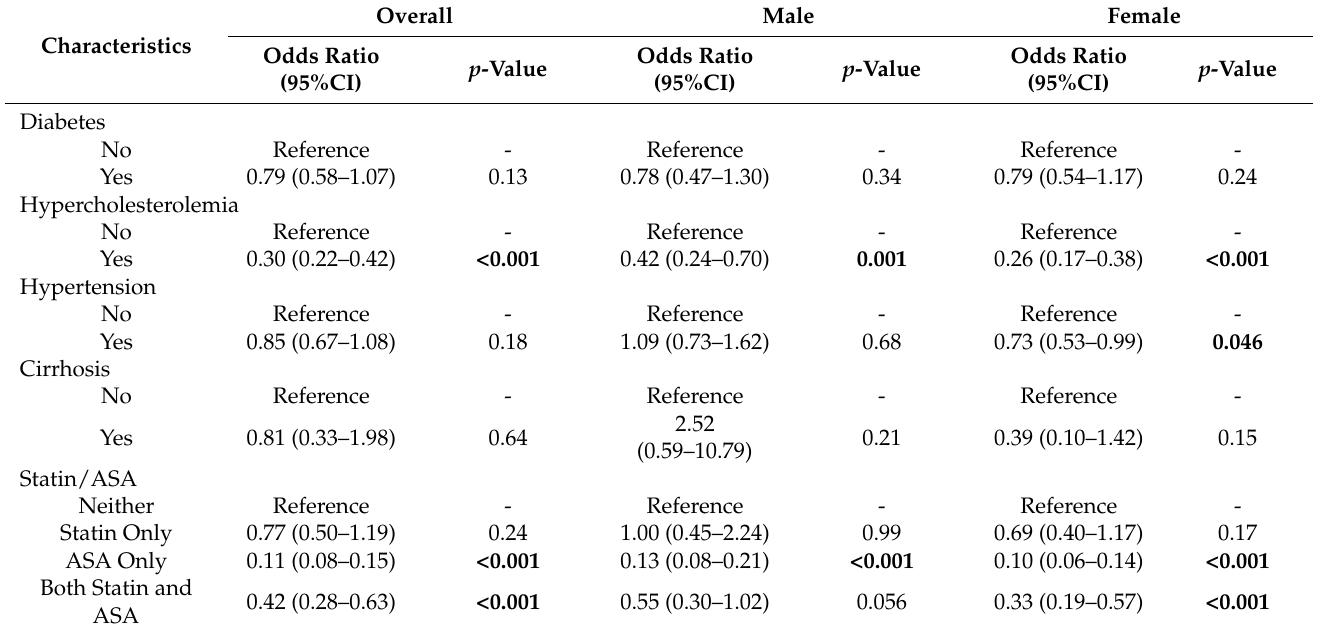
Table 5. Multivariable analysis of factors (after excluding IBD and PSC) evaluated for an association with having gallbladder cancer overall and stratified by